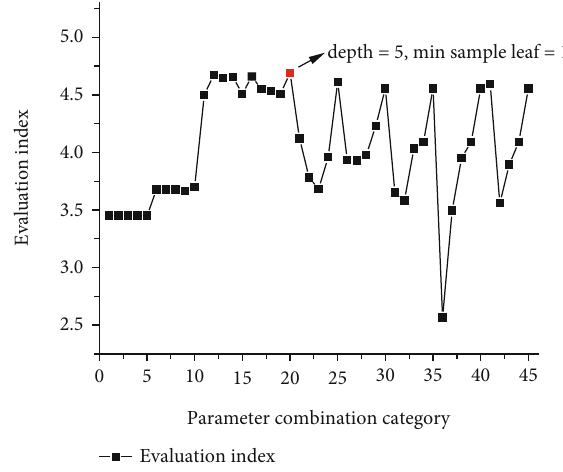
Figure 7: Integrated evaluation